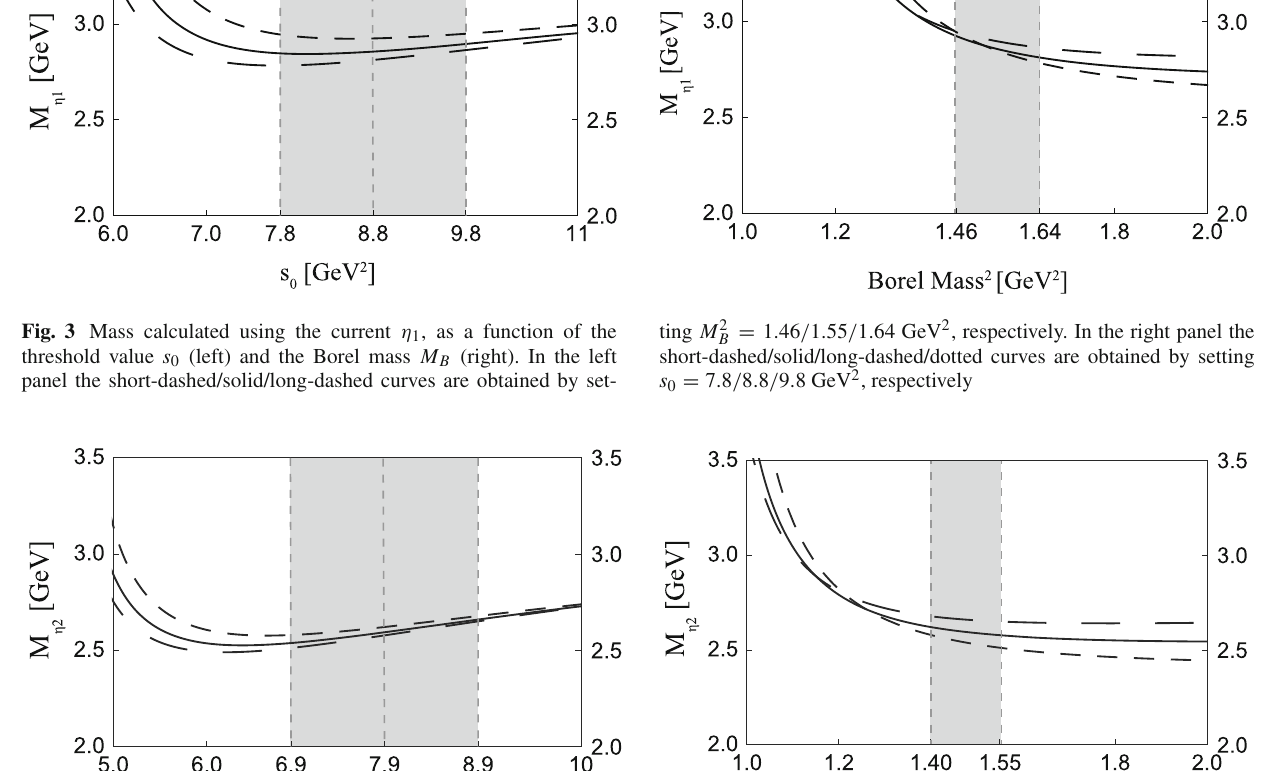
Fig. 4 Mass calculated using the current η 2 , as a function of the threshold value s 0 (left) and the Borel mass M B (right). In the left panel the short-dashed/solid/long-dashed curves are obtained by set-